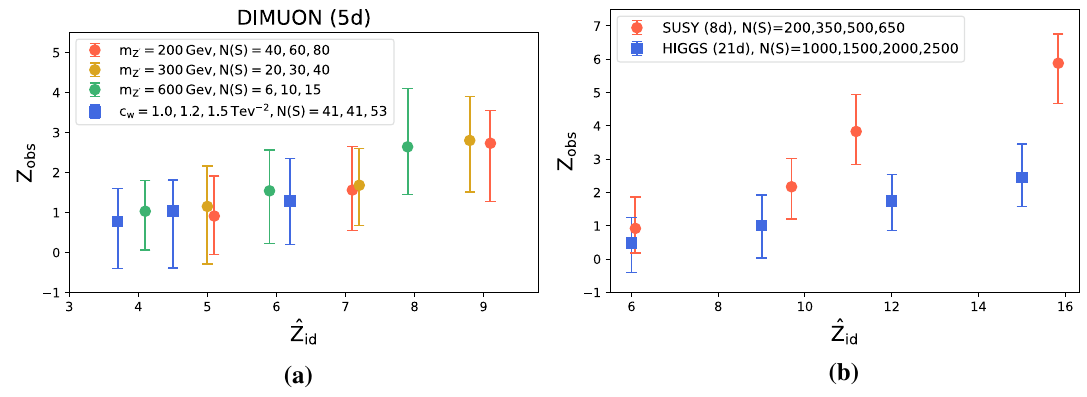
Fig. 2 Observed significance against estimated ideal significance with low-level input features